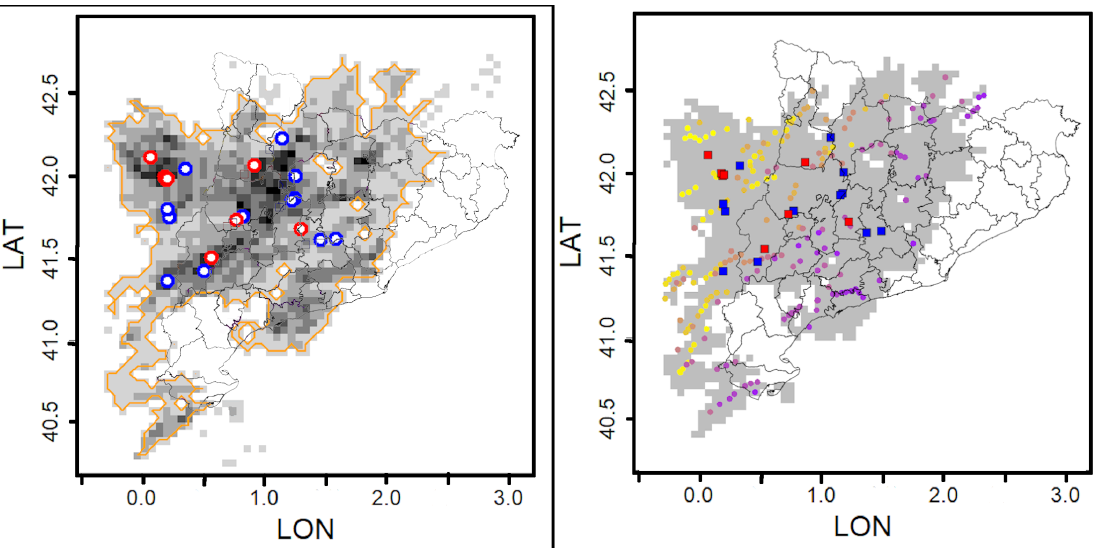
Figure 6. ( Left ) Total lightning area (shaded grey region) associated with multiple-lightning jump warnings (blue dots correspond to multiple-lightning sources and red ones to single sources). The orange line encloses the area associated with the warnings. Case of 10 October 2013. ( Right ) The same as the left panel (LJs marked with blue and red squares), but including the centroids of the thunderstorms identified based on the volumetric radar product (circle